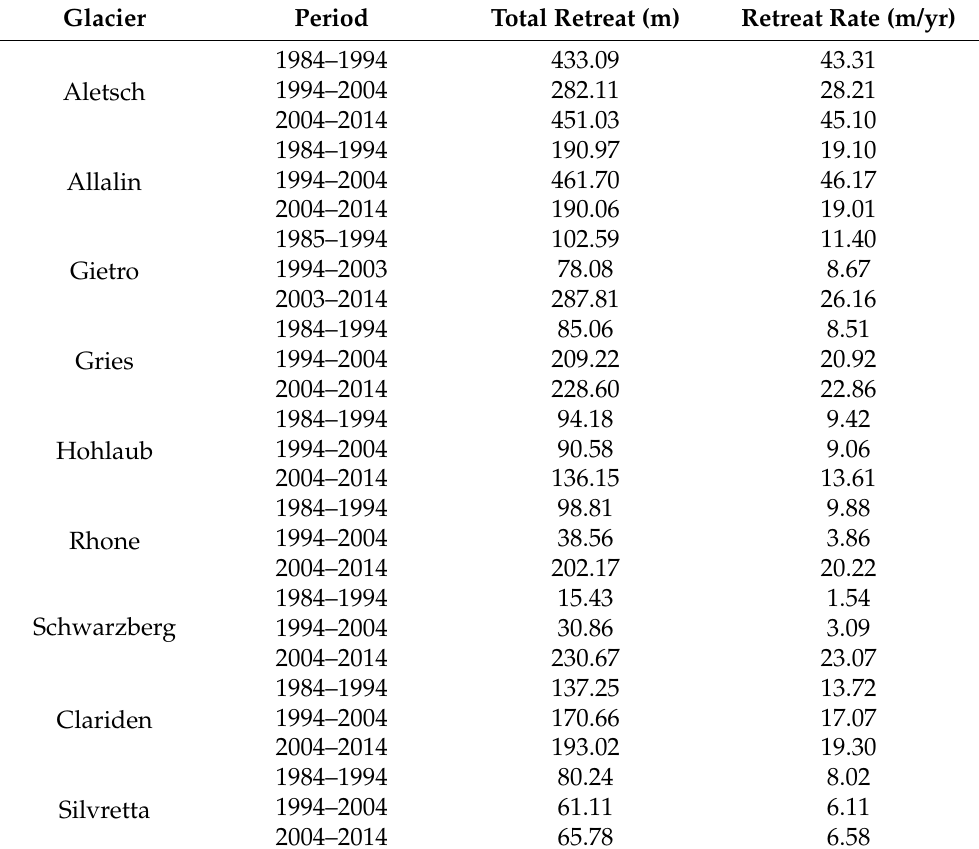
Table 10. Glacier retreat rates during